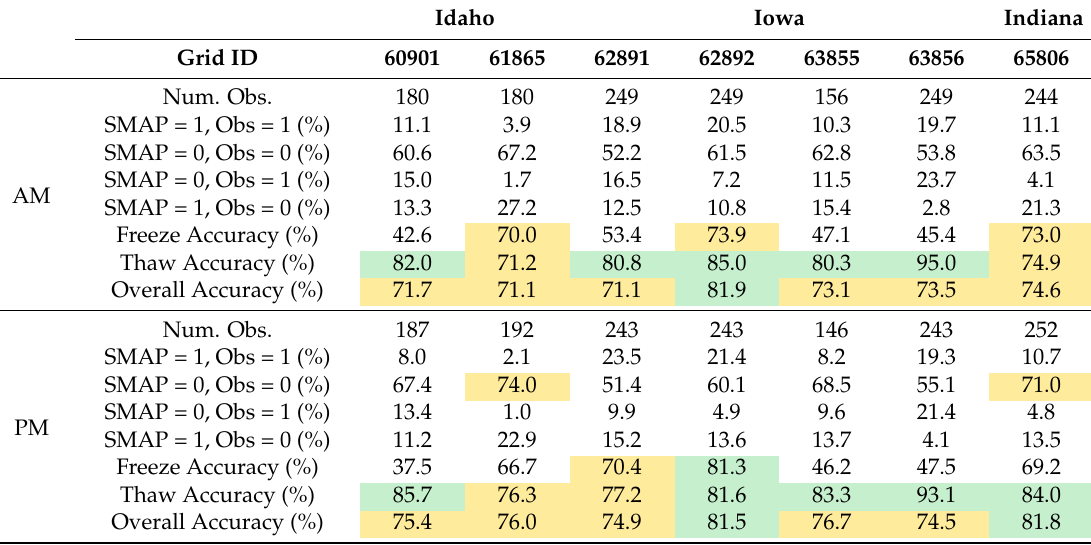
Table 4. Winter (October–March) performance using ∆ (t) thr = 0.5. Values equal to and above 70% (80%) are highlighted in yellow (green). ‘SMAP’ and ‘Obs’ are the SMAP and in situ freeze-thaw state with 0 (1) as thawed